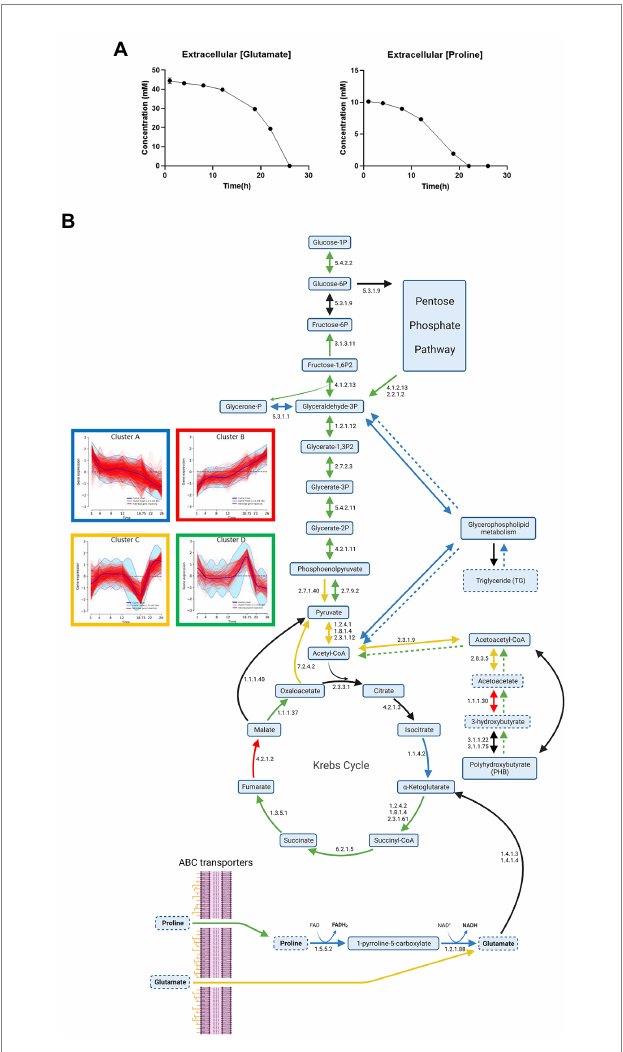
FIGURE 6 Impact of proline starvation on central metabolism during Bordetella pertussis Tohama I culture. (A) Longitudinal evolution of glutamate and proline extracellular concentrations monitored by NMR analyses. (B) Central metabolism gene expression profiles during B . pertussis Tohama I culture. Blue, red, yellow, and green arrows show the enzymes encoded by genes of the clusters A–D (Figure 4A), respectively. Black arrows indicate a discrepancy of cluster between the different enzyme genes. Numbers next to arrow reactions are the EC numbers of the reaction. Dashed arrows are reactions deducted from lipidomic or metabolomic results using the same color code than transcriptomics data. Lipids/Metabolites with dashed outlines were quantified in lipidomic or extracellular metabolomic analyses. This figure was created with BioRender.com.